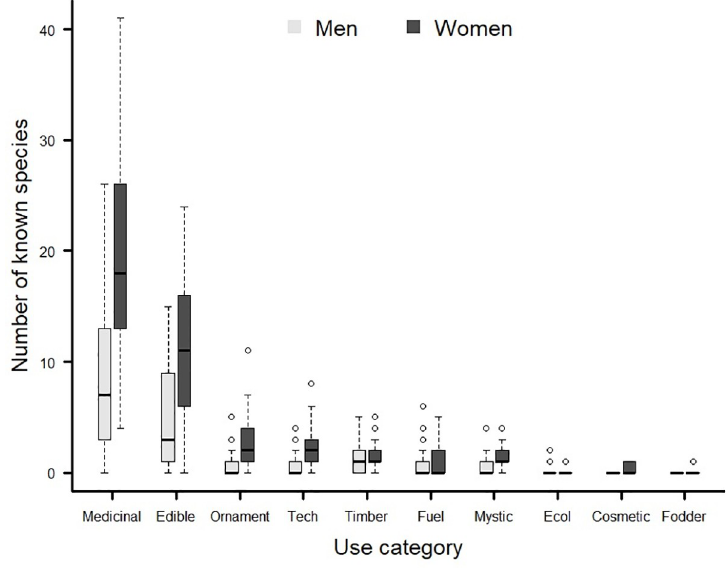
Fig 2. Number of known plant species in use categories by women and men in an urban community in Ouro Preto, in the state of Minas Gerais, southeastern Brazil.